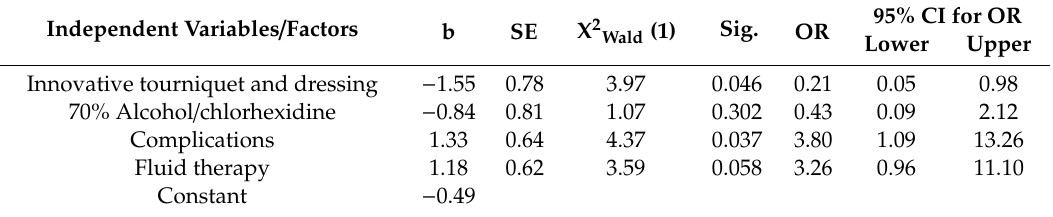
95% CI for OR Sig. OR Wald (1) Lower Upper